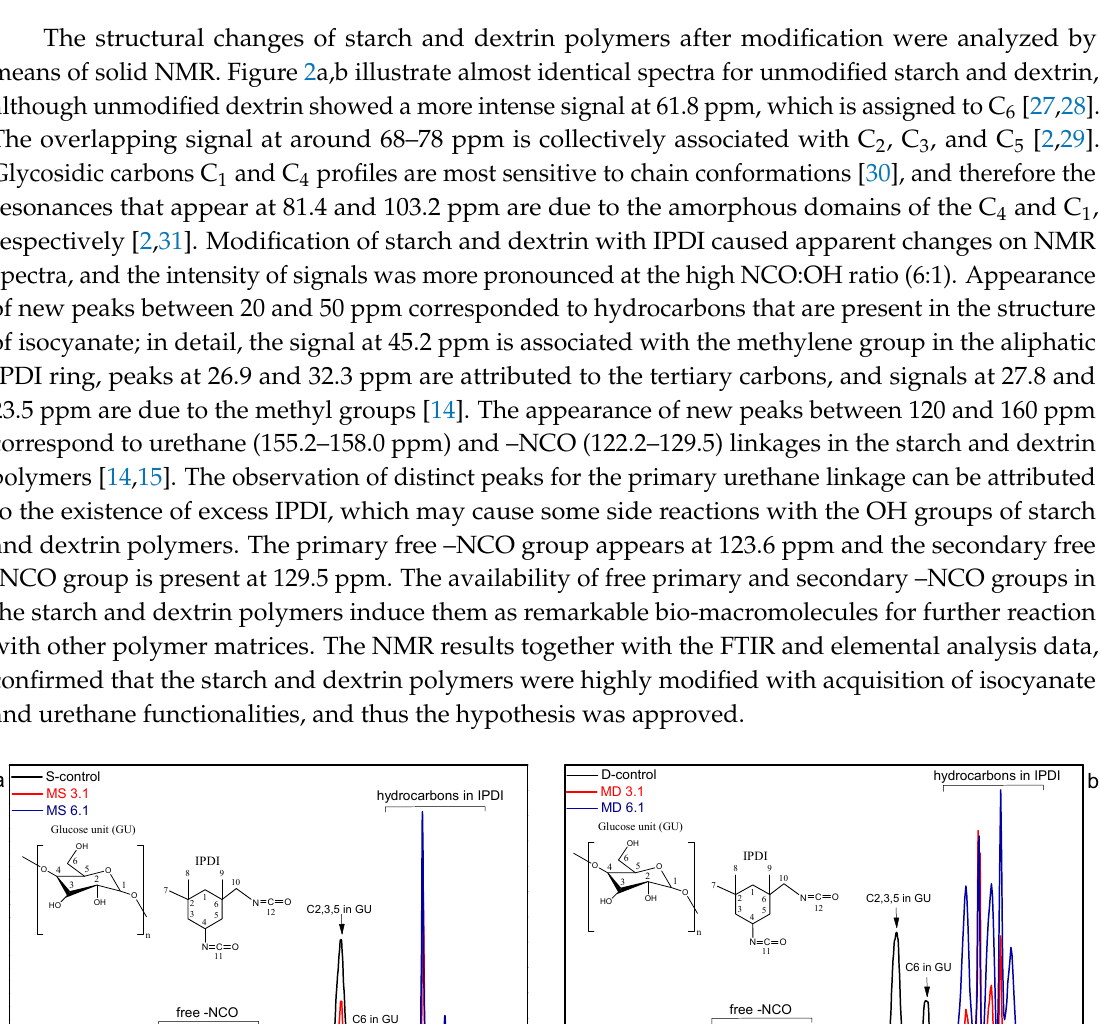
Figure 1. Fourier transform infrared spectroscopy (FTIR) spectra of IPDI, S-control, MS 3.1 and MS